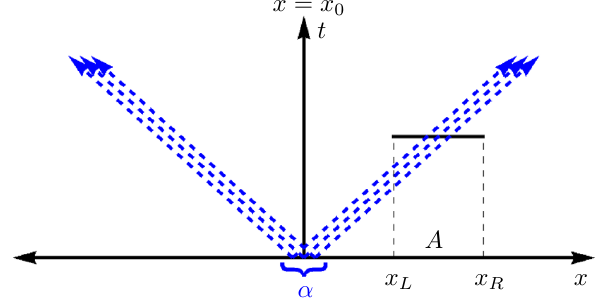
Figure 3 . Pictorial representation of the universal contribution to the spread of entanglement entropy after a local quantum quench in 2d CFTs. The state at t = 0 is the vacuum state perturbed by a local operator smeared over a region of compact support (cid:24) (cid:11) . The state evolves under the CFT Hamiltonian H for t > 0, generating an entangled pair of wave packets that move in opposite directions at the speed of light. The wave packets eventually increase the entanglement entropy of region A = f x j x 2 [ x L ; x R ] g ( x L (cid:17) x c (cid:0) R , x R (cid:17) x c + R ), and then decrease it as they disperse to